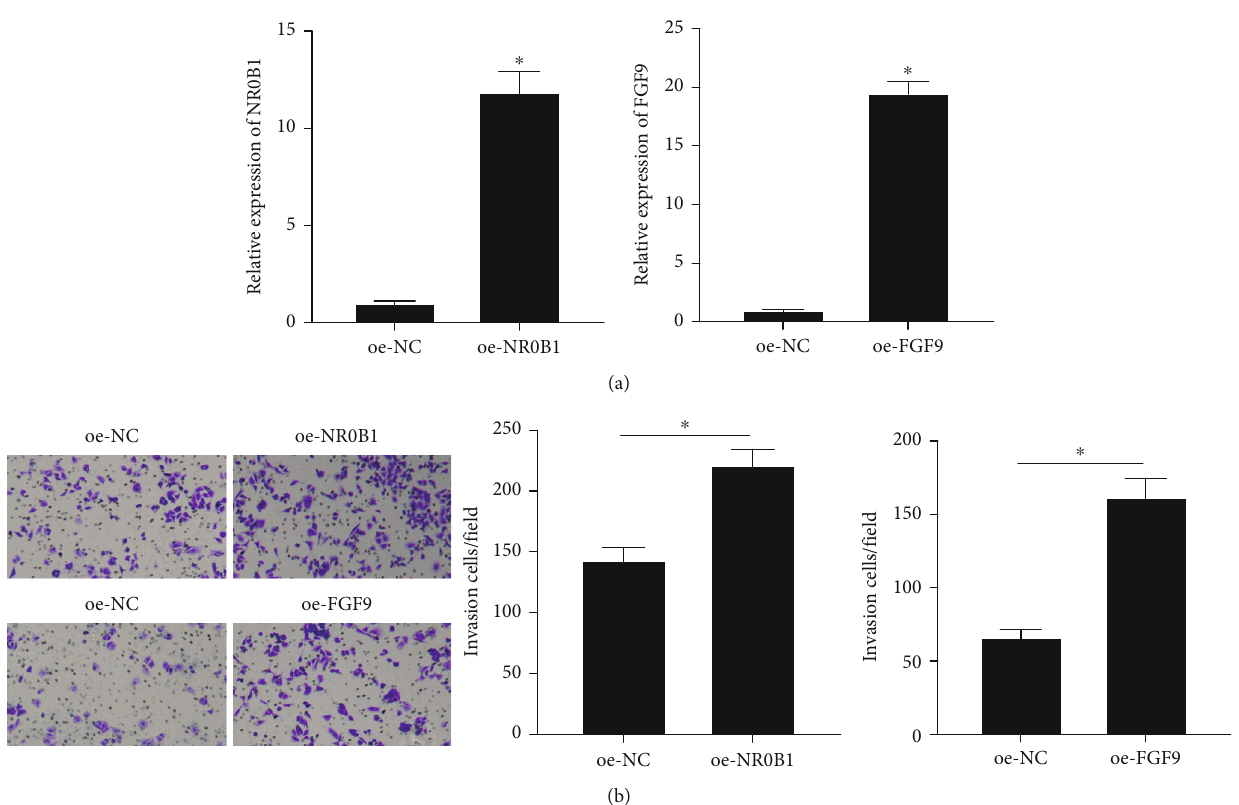
Figure 8: E ff ects of immune-related genes on macrophage chemotaxis. (a) The transfection e ffi ciency of oe-NR0B1 and oe-FGF9 plasmids. (b) The e ff ect of hepatoma cells overexpressing NR0B1 and FGF9 on macrophage chemotaxis ( ∗ P < 0 : 05